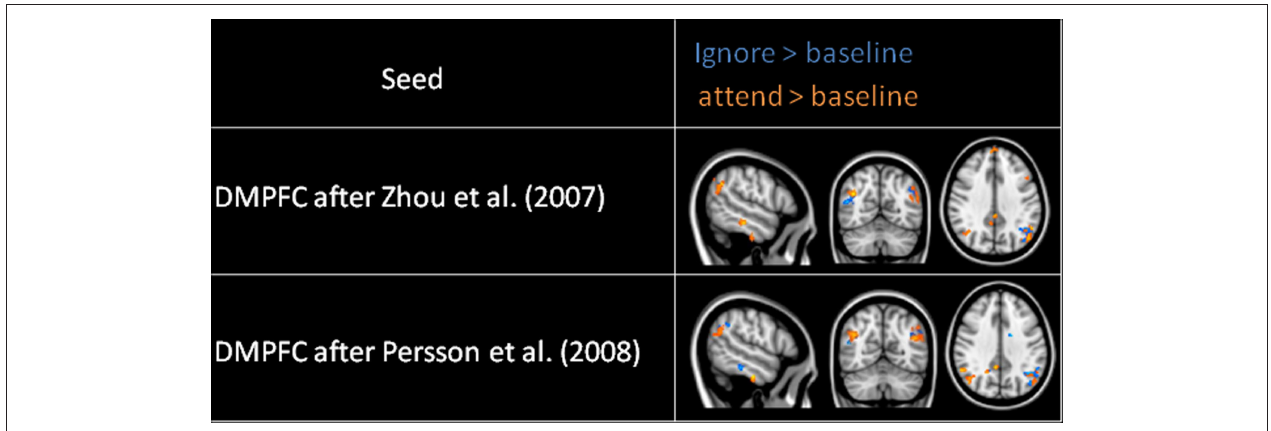
FIguRe 6 | Functional connectivity map obtained using dmPFC defined after Zhou et al. (2007; schizophrenia literature) and Persson et al. (2008; Alzheimer’s disease literature) . Ignore > baseline is represented in blue; attend > baseline in orange. Image thresholded at p < 0.005, 20-voxel threshold, colors run from 2 (dark) to > 5